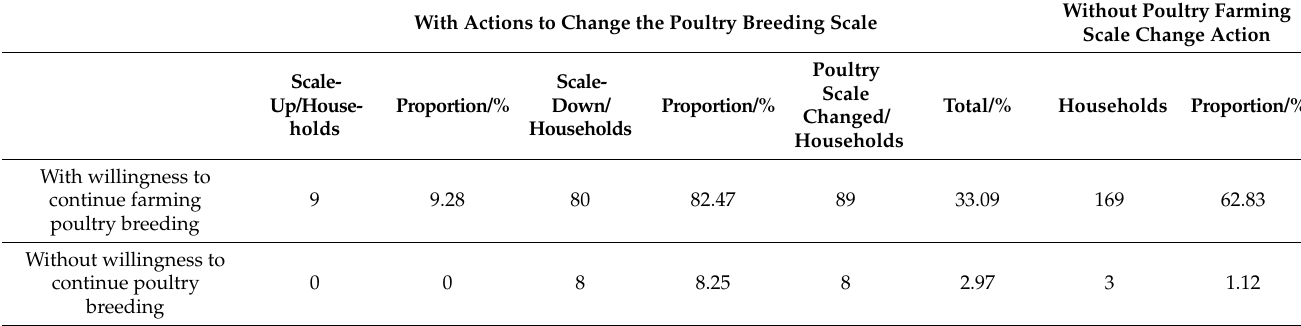
Table 4. Poultry farmers’ willingness and scale change